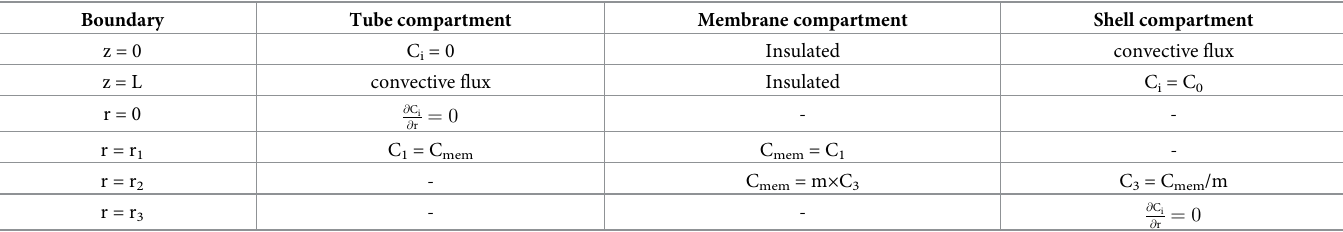
Table 1. The employed boundary conditions in all domains of PMC.